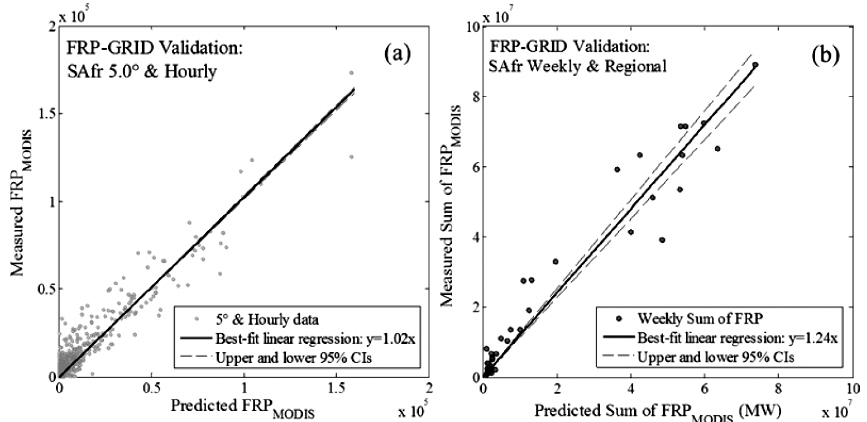
Figure 7. Evaluation of the bias adjustment factors used in the SEVIRI FRP-GRID product. Results are based on coincident SEVIRI and MODIS observations taken between May 2008 and May 2009, collected and matched as shown in Fig. 6. The nearly 1 : 1 relationship between the predicted and measured values of MODIS FRP demonstrates the unbiased nature of the adjustment factor applied at (a) 5.0 ◦ grid cell resolution and hourly temporal resolution in the FRP-GRID product, in this case for 5.0 ◦ grid cells in Southern Africa. In (b) the effect of accumulating observations over weekly intervals and over the entire Southern Africa LSA SAF geographic region demonstrates that the FRP-GRID product tends to still deliver a result that underestimates the sum of FRP measured by MODIS at this broader spatio-temporal scale, owing primarily to the numerous observations in which SEVIRI failed to detect at least one active fire pixel in a 5.0 ◦ grid cell in which MODIS did successfully detect a fire. Full results of the evaluation exercise for all four geographic regions are presented in Table